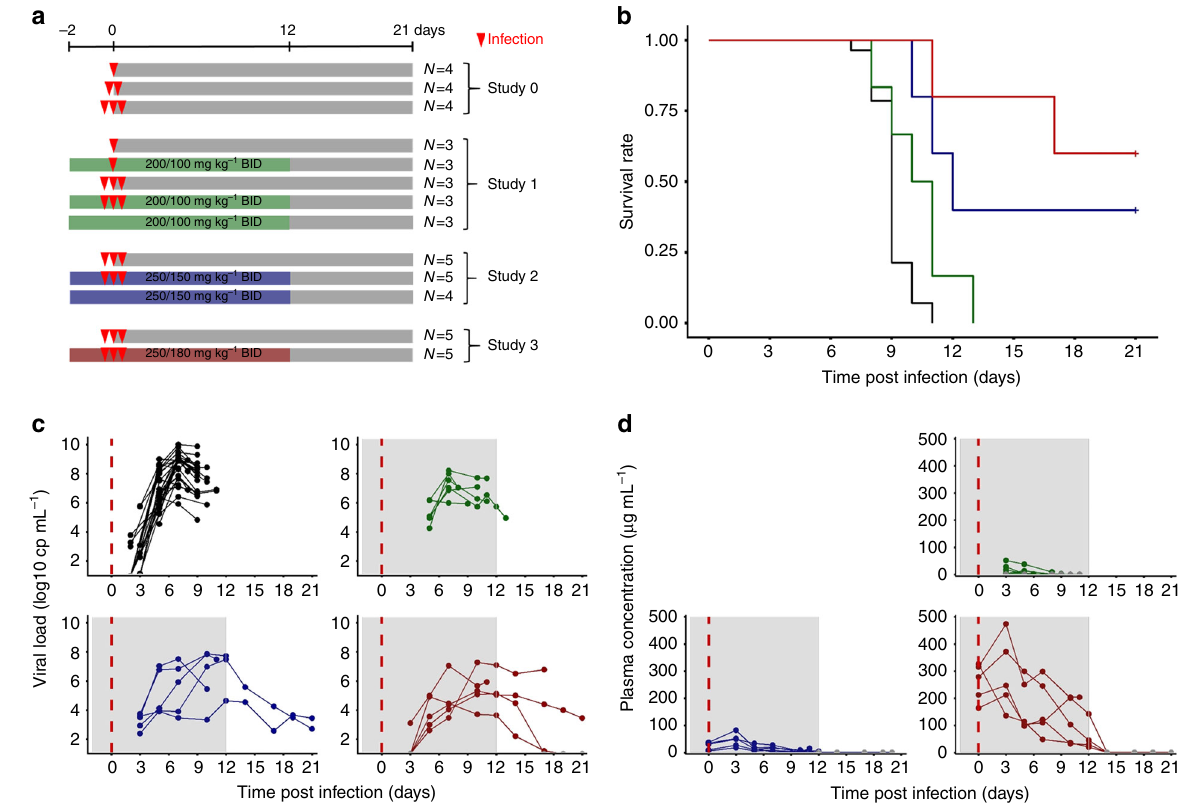
Fig. 1 Survival and virological data. a Design of the four infected NHP experiments. b Survival curves. c Ebola virus plasma viral load. d Favipiravir plasma concentrations. Dosing regimen groups were untreated (black), 100 mg kg − 1 BID (green), 150 mg kg − 1 BID (blue), and 180 mg kg − 1 BID (red). Gray